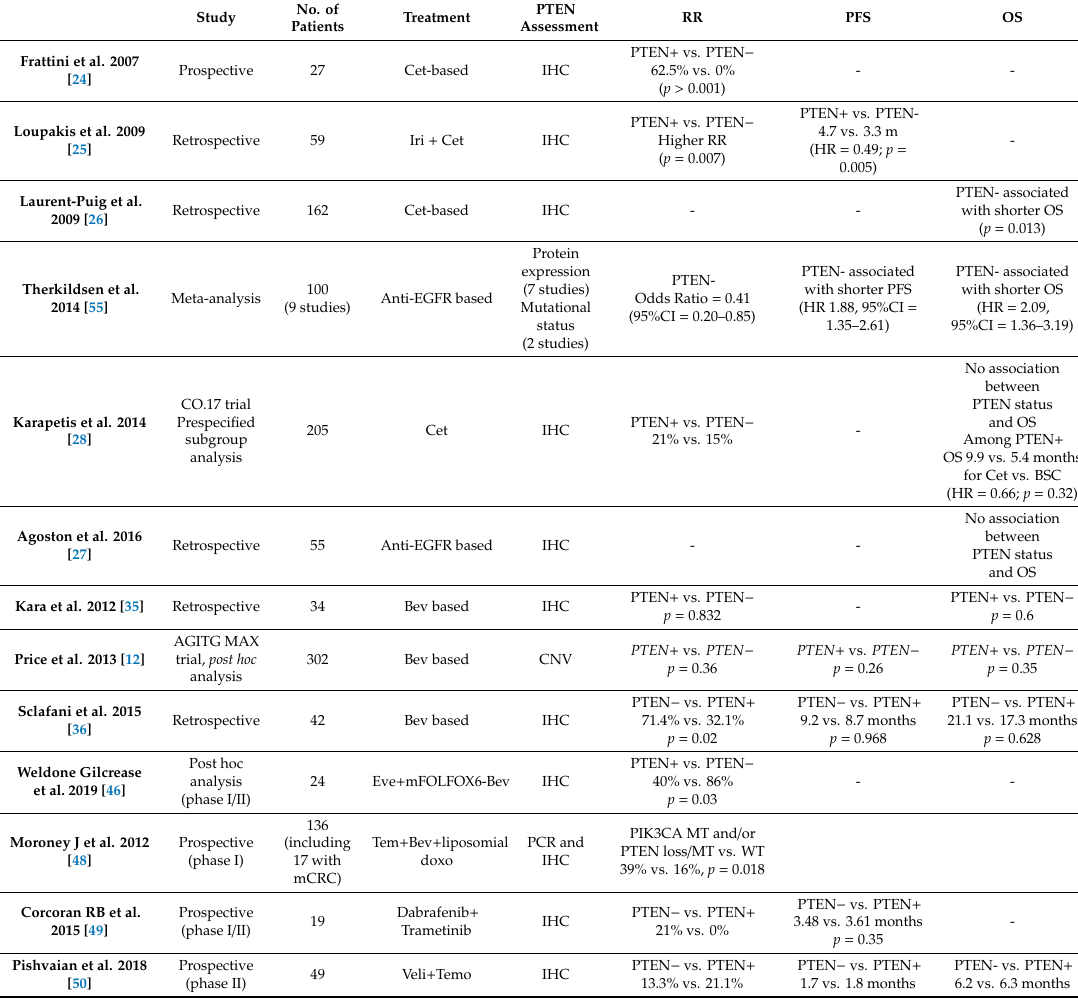
Table 1 summarizes clinical evidences on PTEN as a predictive factor. Bev: bevacizumab; BSC: best supportive care; Cet: cetuximab; Doxo: doxorubicin; Eve: everolimus; IHC: immunohistochemistry; Iri: irinotecan; m: months; MT: mutation; N: number; OS: overall survival; PFS: progression free survival; RR: response rate; Temo: temozolomide; Tems: temsirolimus; Veli: veliparib; WT: wild